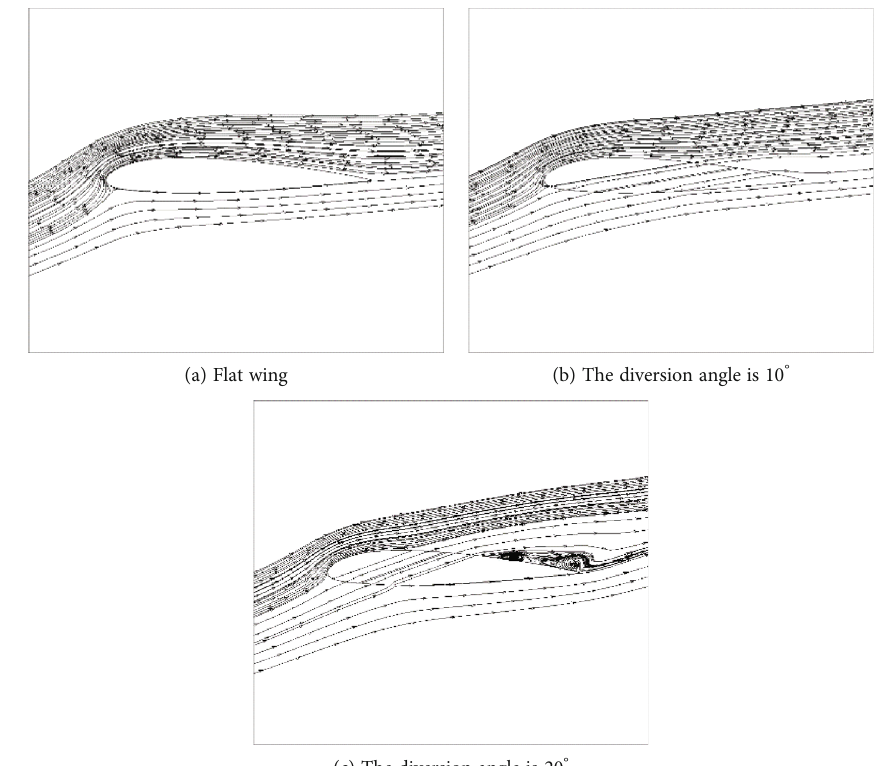
Figure 19: Fluid streamline diagrams of grid fusion lifting surface with di ff erent diversion angle ( Ma = 0 : 6 α = 16 ° z / b = 0 : 75